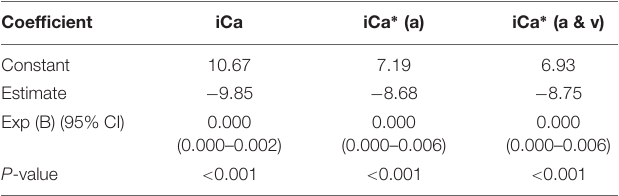
TABLE 3 | Independent contributing factors to low bone turnover disease, defined by a 1-84 PTH/ non 1-84 PTH ratio ≤ 1 and iPTH < 420 pg/mL, in the multiple regression analysis.